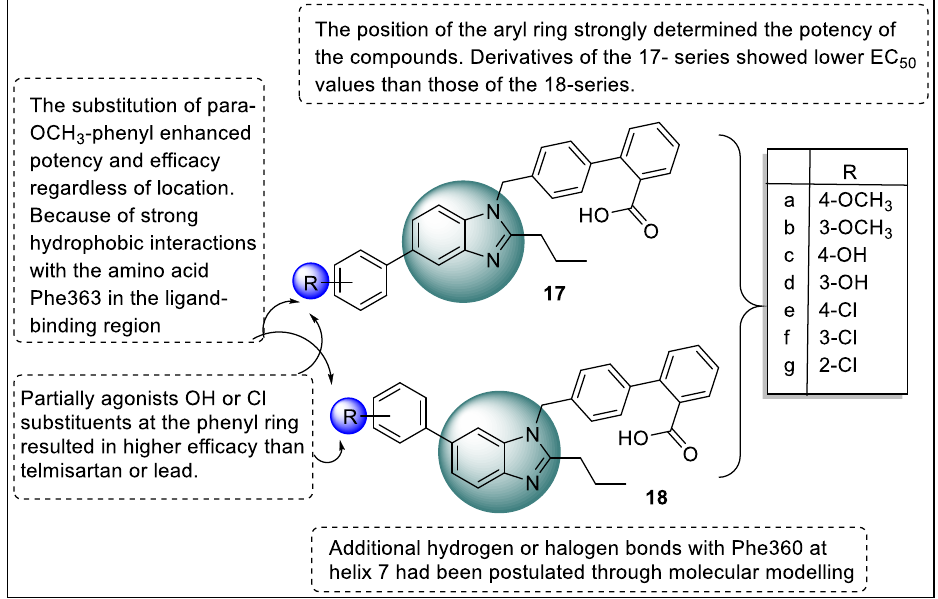
Figure 21. Structural activity relationship of Benzimidazole hybrids ( 17 and 18 ) as potent PPAR ligands.